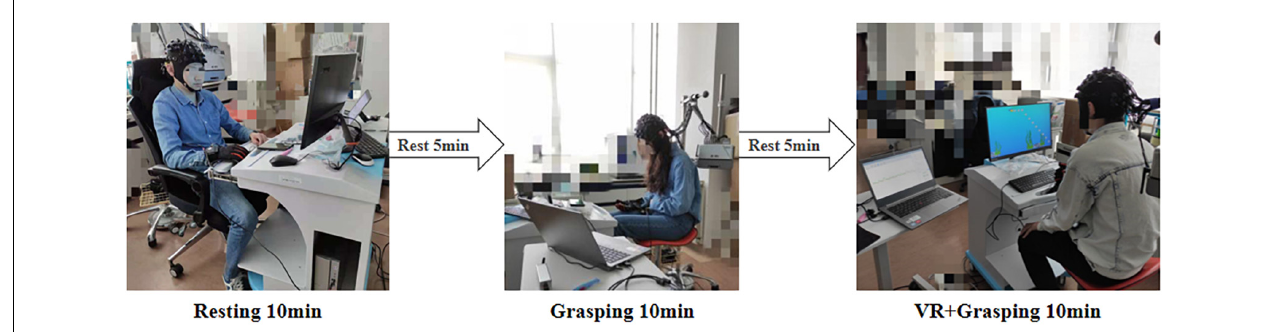
FIGURE 3 | Experimental process and scenario. First, the subjects rest for 10 min, then rest for 5 min, then grasping movements for 10 min, then rest for 5 min, and finally VR grasping movements for 10 min.